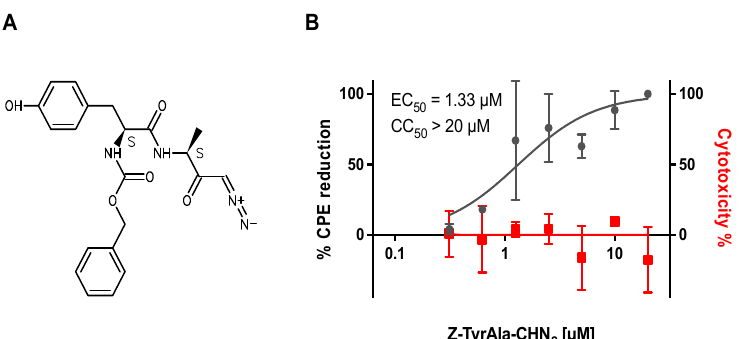
Figure 1. ( A ) Structure of Z-Tyr-Ala-CHN 2 . ( B ) Antiviral activity of Z-Tyr-Ala-CHN 2 against SARS- CoV-2 from the primary screen performed in VeroE6-eGFP. The SpotTotalAreaCh2 of the green fluorescent protein (GFP) signal was used to quantify CPE reduction. Toxicity was determined on the same cell line and was quantified using ATPlite. The results represent data from two to three independent experiments. CPE, cytopathic effect; CC 50 , half-maximal cytotoxic concentration; EC 50 , half-maximal effective concentration; eGFP; enhanced GFP; GFP, green fluorescent protein; SARS-CoV-2, severe acute respiratory syndrome coronavirus 2.